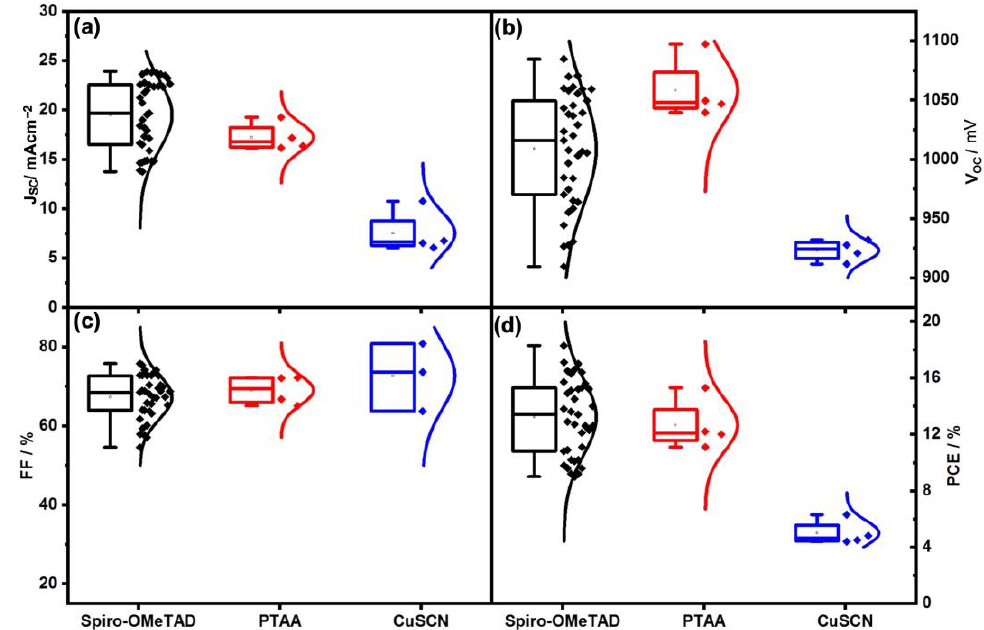
Figure 8. Statistics of J SC ( a ), V OC ( b ), FF ( c ), and PCE ( d ) related to gold-based solar cells with different HTMs and densification layers, including Spiro-OMeTAD, PTAA, and CuSCN. Table 5. J-V parameters of the carbon-based devices with and without densification by spiro-OMeTAD. PCE (max) stems for the record efficiency scanned in the backward direction and 20 mV s −1 scan rate. Densification